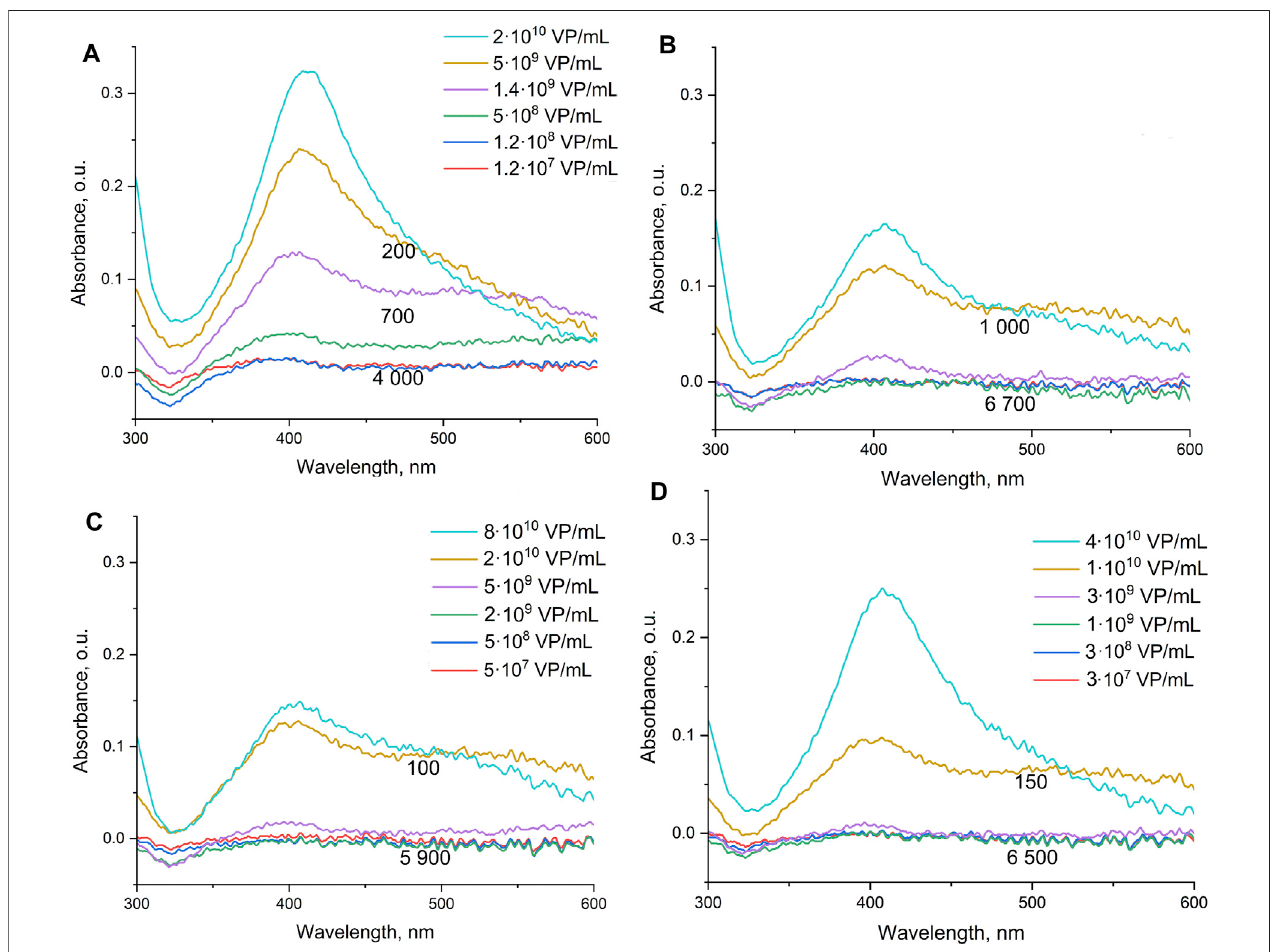
FIGURE3| Spectraofsampleswithdifferentquantitiesofthein fl uenza Avirus (A) ,allantoic fl uid (dilutions arethesame asforin fl uenza Avirus) (B) ,in fl uenza B (C) , and Newcastle disease virus (D) . Numbers indicate the mean SERS intensity of BODIPY FL in the probes. The concentration dependencies were described earlier in Zhdanov et al.